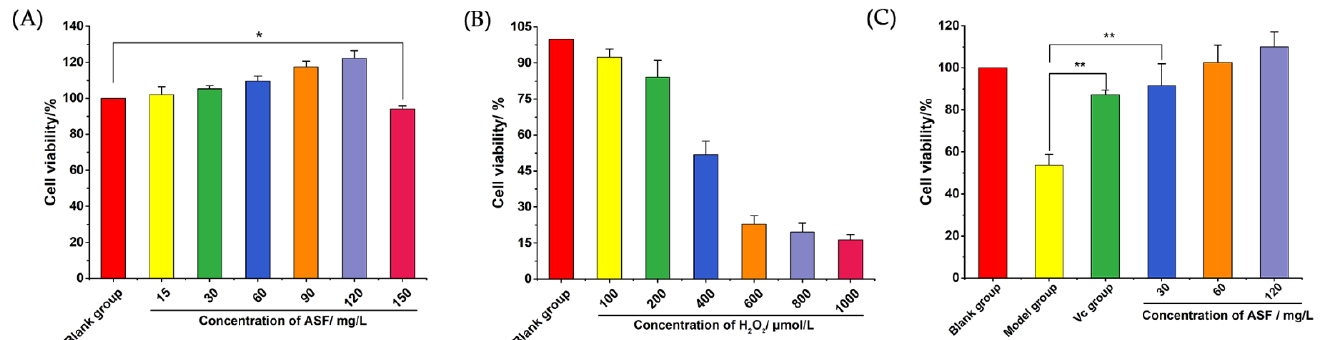
Figure 1. Results of toxicity test. ( A ) Effects of total flavonoids of A. senticosus on the viability of RAW 264.7 cells. ( B ) The effects of H 2 O 2 on proliferation of RAW 264.7 cells. ( C ) The protective effects of total flavonoids on oxidative damage of RAW 264.7 cells. Note: For the comparison between the two groups, * indicates significant difference at p < 0.05. ** indicates extremely significant difference at p < 0.01.